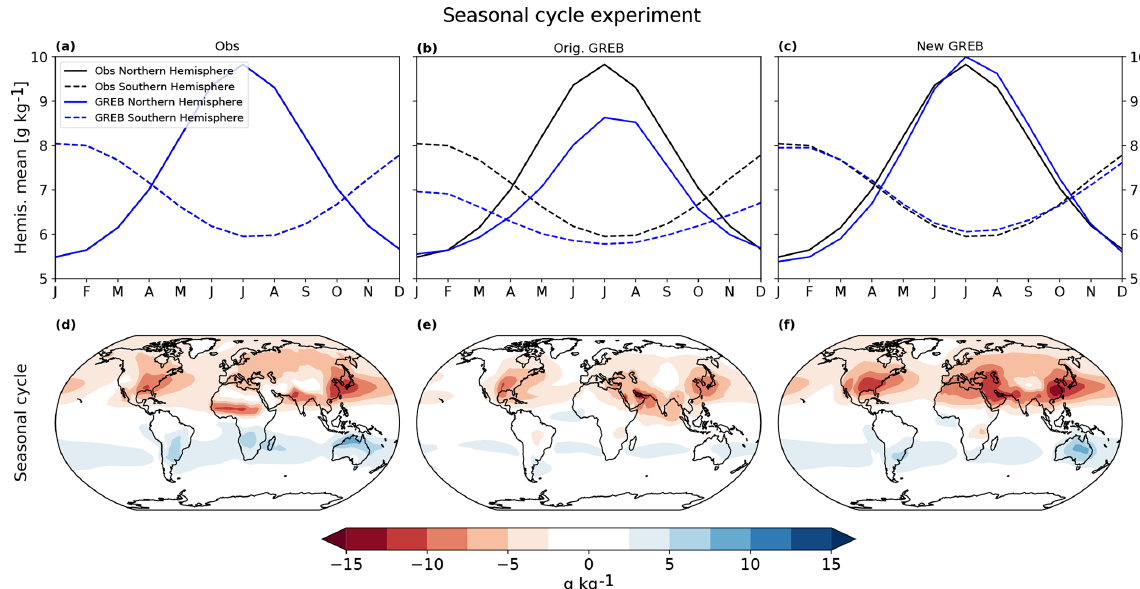
Figure 9. Annual cycle of specific humidity with seasonal varying flux corrections (a, d) and annual mean flux corrections for original GREB (b, e) and improved GREB (c, f) in gkg − 1 . The top row shows the northern (solid) and southern (dashed) hemispheric mean for observations (black) and GREB (blue). The bottom row shows the respective seasonal cycle (DJF minus JJA). For the seasonally varying flux corrections (a) , GREB (blue) matches observations (black).